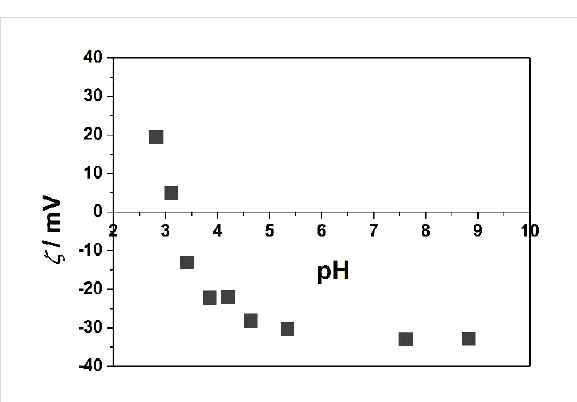
Figure 2: Variation of zeta potential ( ζ ) with pH of TNWs in 10 − 3 mol dm − 3 NaBr aqueous solution. γ (TNW) = 1 × 10 − 2 g dm − 3 . θ = 25